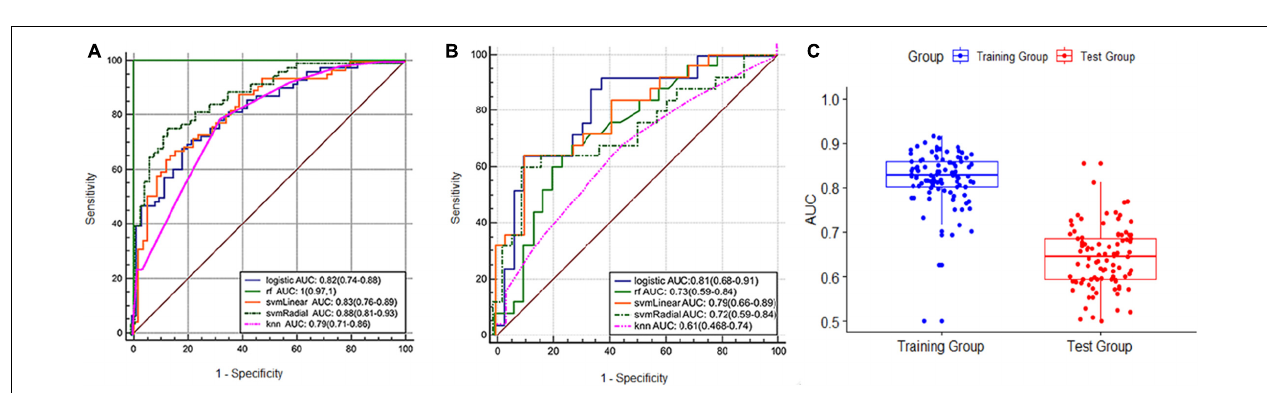
FIGURE 3 | (A) ROC curve of the training set. (B) ROC curve of the validation set. (C) boxplot of the results of 100-fold LGOCV in the training and validation sets.